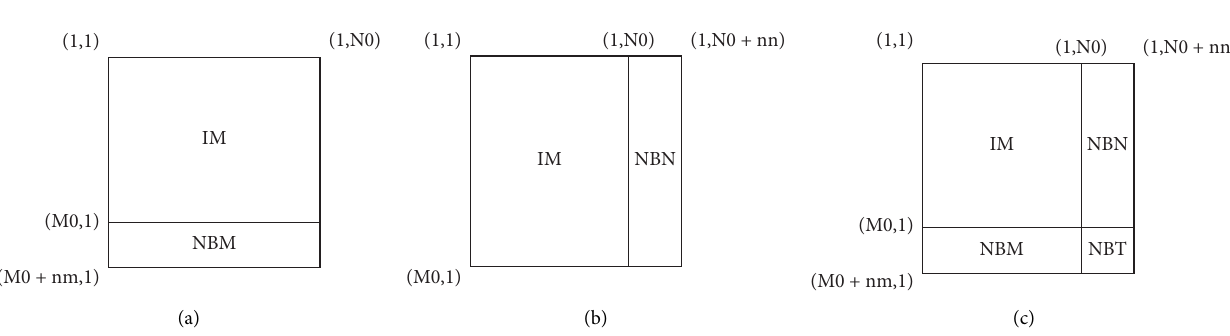
Figure 3: The rules of matrix combination.